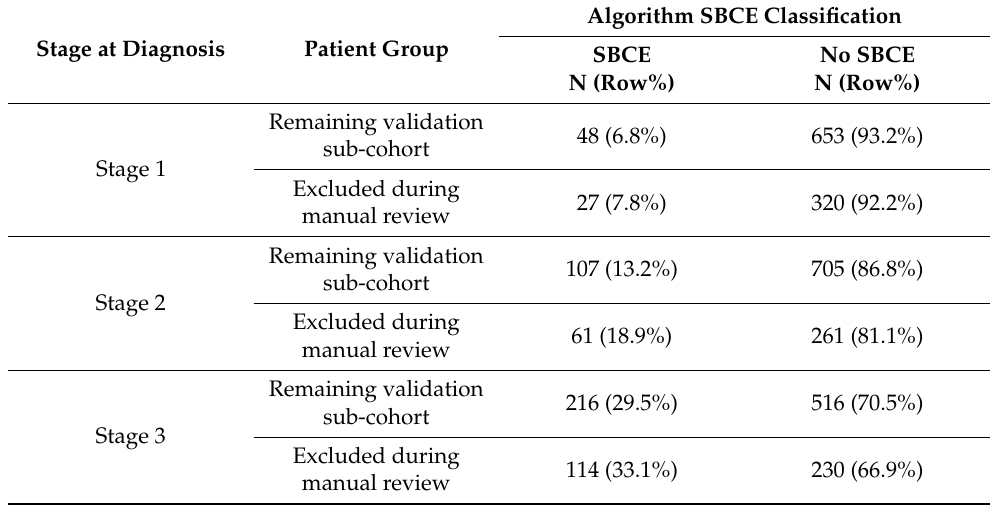
Table A9. Algorithm classification as experiencing a second breast cancer event (SBCE) stratified by stage at diagnosis and exclusion during manual review.